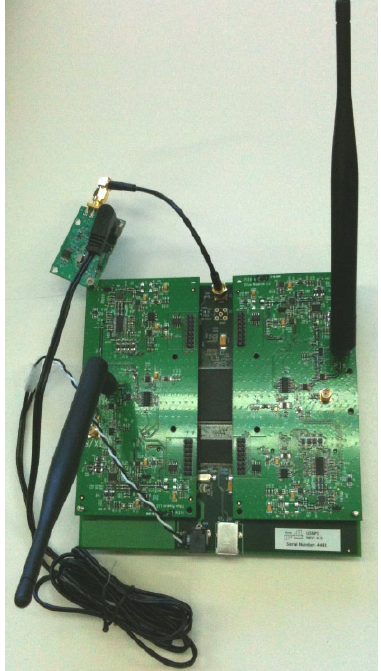
Figure 14. USRP board with auxiliary 52 MHz clock